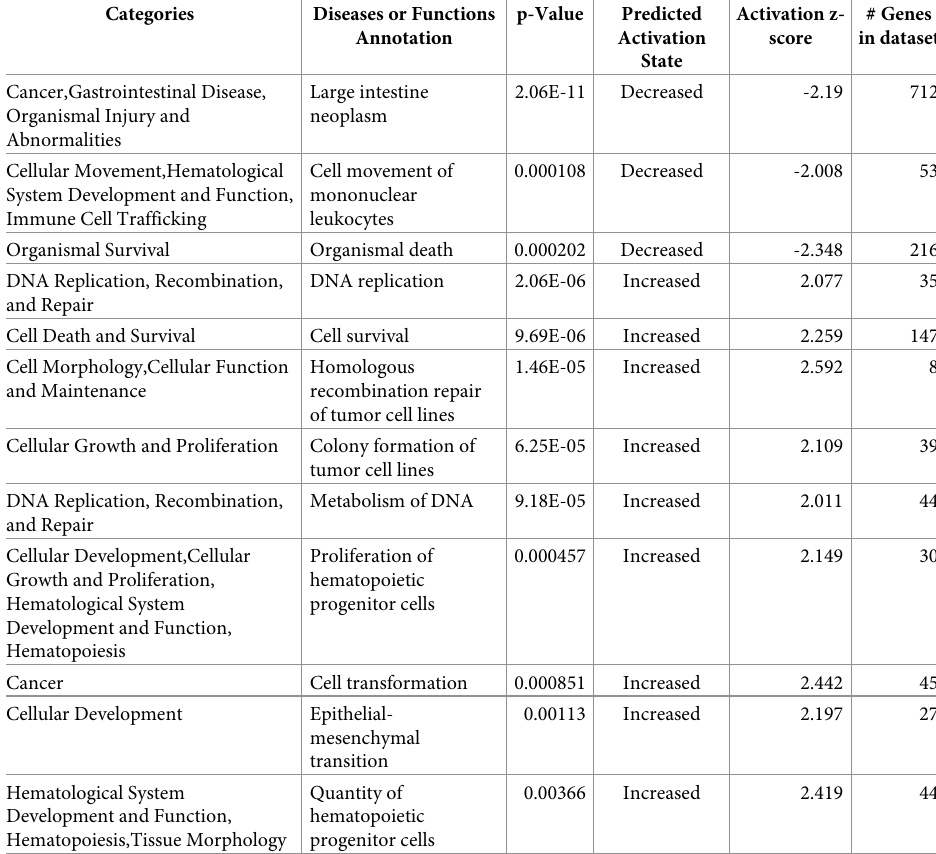
Table 6. Disease and functions predicted for AGS-EBV SC tumors vs AGS SC tumors.